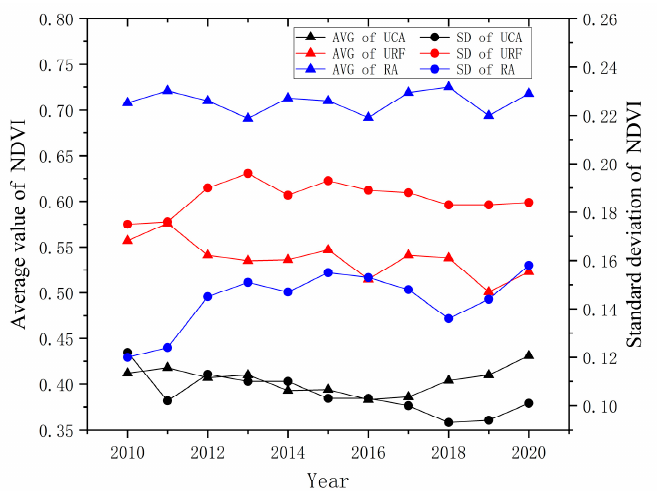
Figure 7. NDVI calculation chart of Wuhan urban core areas, urban-rural fringe, and rural areas from 2010 to